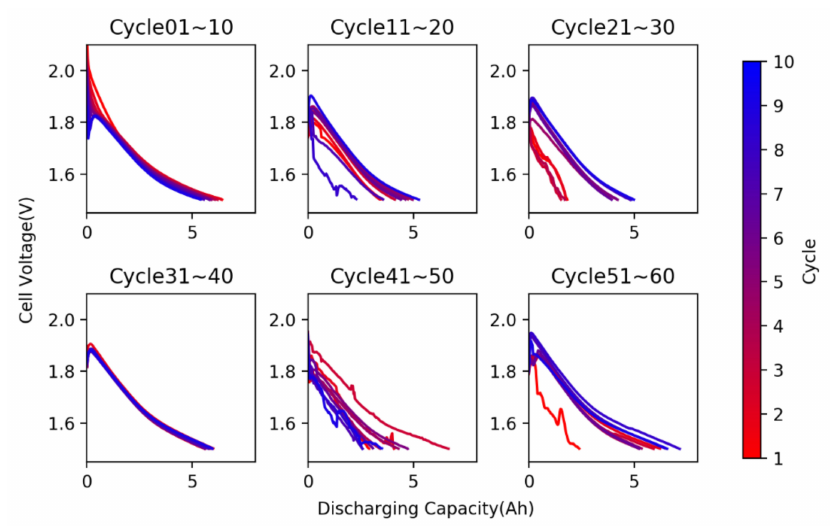
Figure 5. The discharging curves of cell #2 during aging